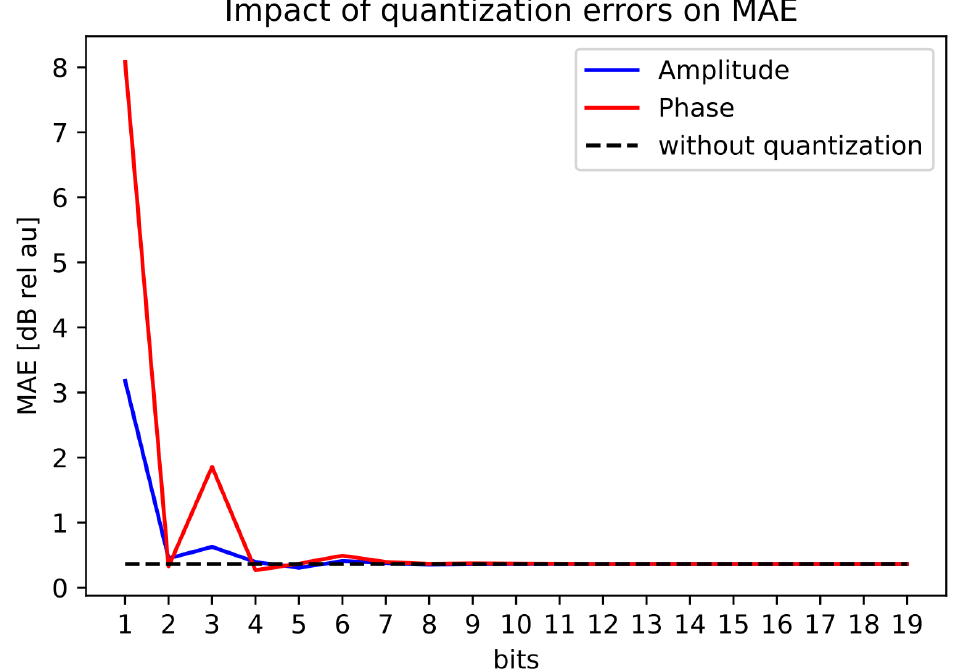
Figure 8. Quantization effect on the MAE for the ramped beampattern mask with BW = 70 ◦